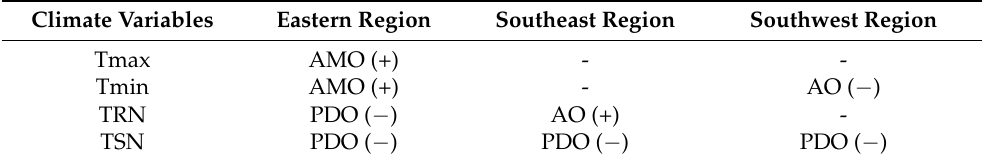
Table 5. Comparison of the link between climate indices and climate variables in the three southern Quebec hydroclimate regions (1950–2000). Summary of canonical correlation analysis results.